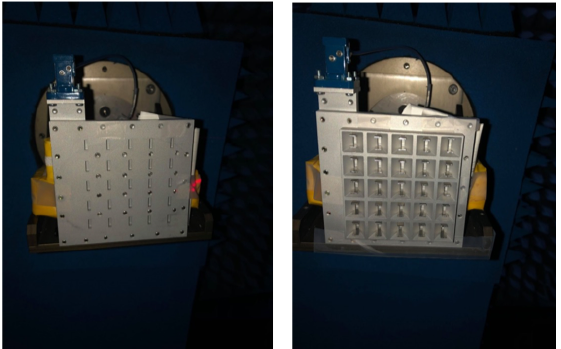
Figure 14. Photographs of experimental setup in anechoic chamber for measurements of far-field radiation patterns: ( left ) without horns; and ( right ) with horns.